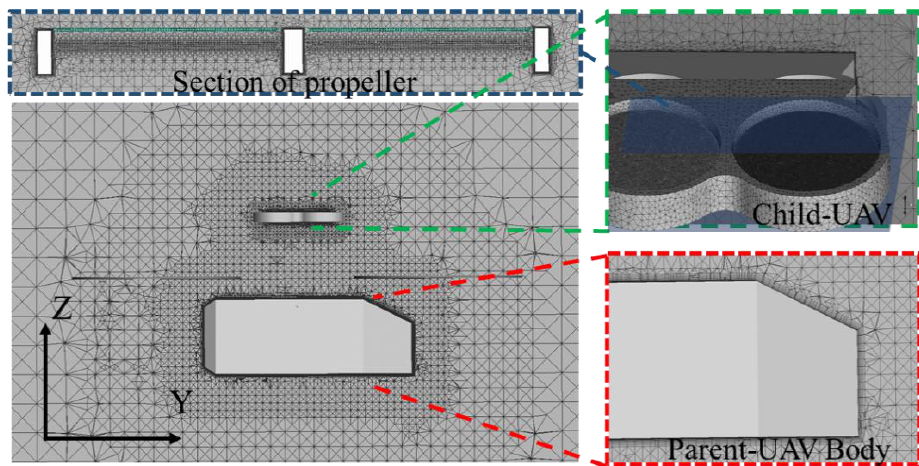
Figure 7. Mesh detail.